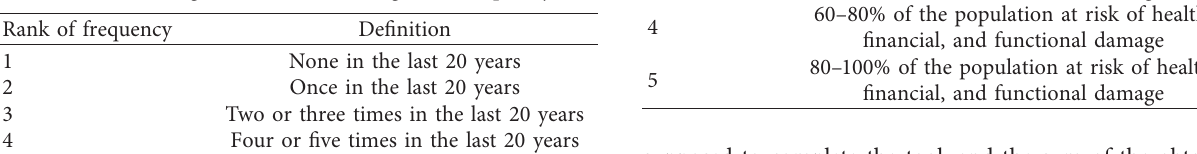
Table 2: Ranking the hazard according to its frequency.